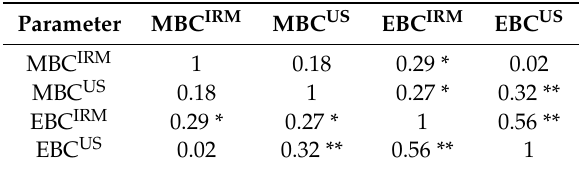
Table 8. Matrix of Pearson correlation coe ffi cients (r) between major microbial quality indicators of udder surface samples ( n = 77) and individual raw milk samples ( n = 77). Parameter MBC IRM MBC US EBC IRM EBC US MBC IRM 1 0.18 0.29 * 0.02 MBC US 0.18 1 0.27 * 0.29